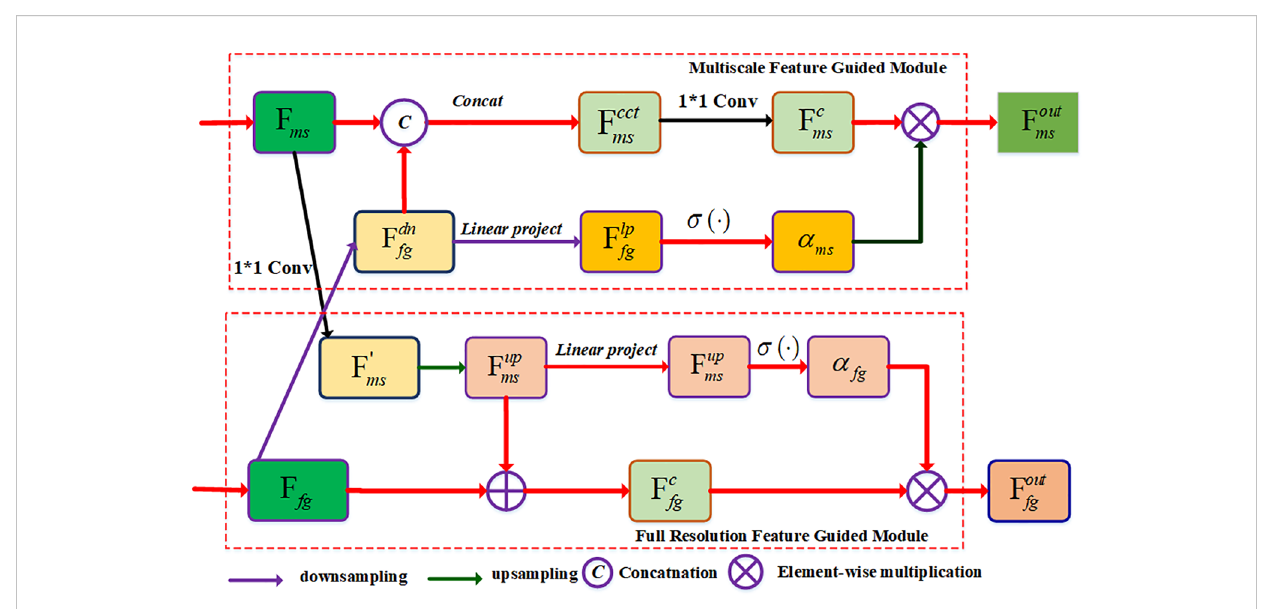
FIGURE 4 The network structure of the BAF module. Two input features F ms and F fg are from the output features of the MSFF and FSFF branches, respectively. The BAF module contains a multi-scale feature guided (MSFG) module and a full resolution feature guided (FRFG) module. The MSFG module is used to generate the multi-scale feature while the FRFG module is used to generate the full-scale